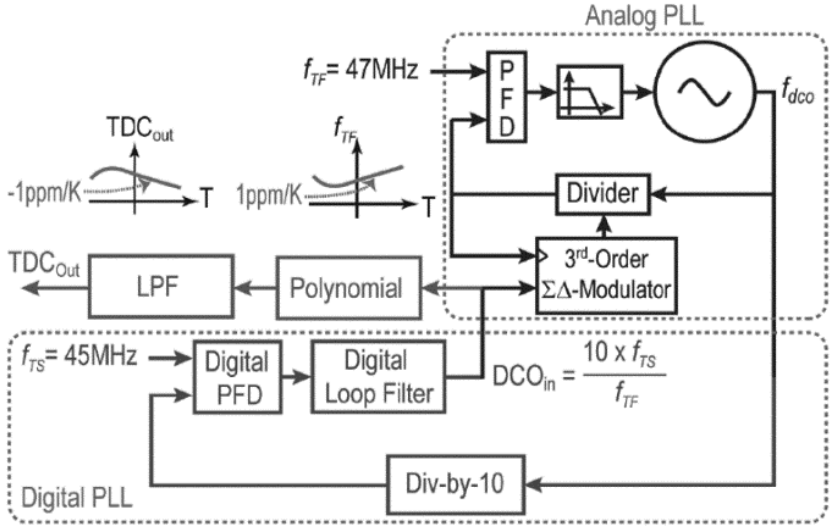
Figure 25. Block diagram of temperature measurement with the PS-UCRB sensor. Reproduced with permission from [120]. Copyright © 2017, IEEE.